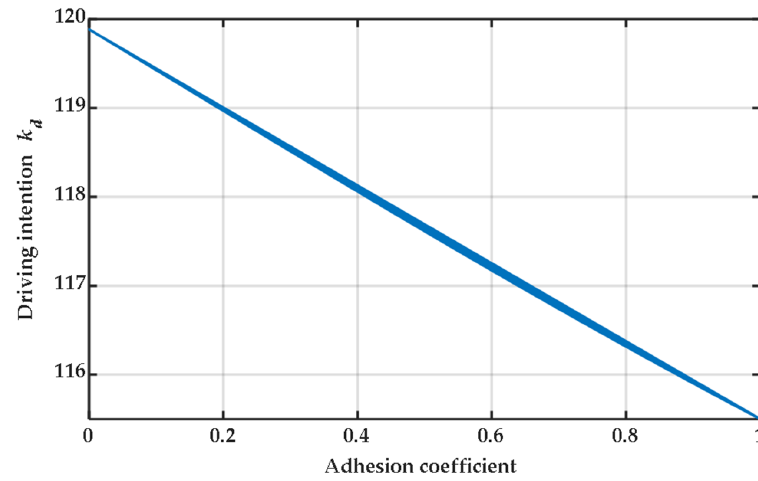
Figure 3. Random data validation for deep neural network.